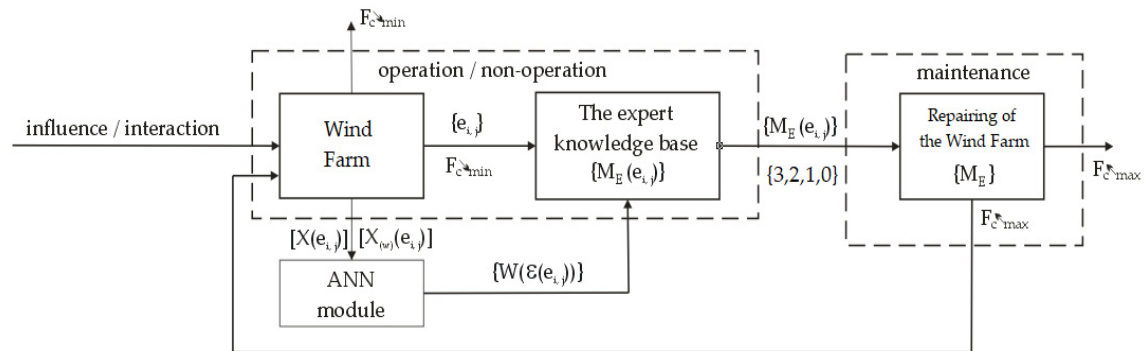
Figure 1. A schematic of the process of exploitation of a technical object using an artificial neural network.